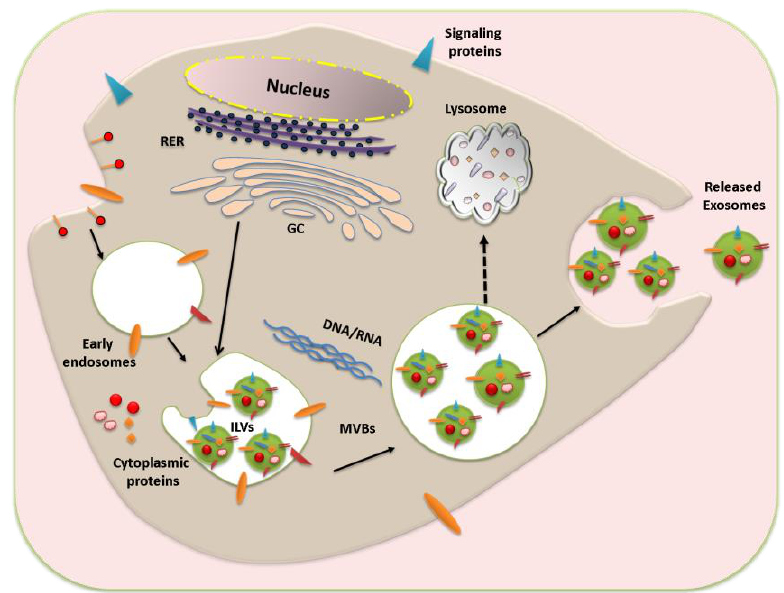
Figure 2. Schematic representation of exosome biogenesis and release. Exosome generation starts with early endosome formation during endocytosis. The membrane proteins are internalized through clathrin-coated vesicles and delivered to early endosomes. This leads to intraluminal vesicles (ILVs) formation by inward budding of the limiting membrane and multi vesicular bodies (MVBs) are formed. Upon maturation the exosome-filled MVBs are either sent to lysosomes for degradation or fused with the plasma membrane to release exosomes to the extracellular milieu. RER: Rough Endoplasmic Reticulum, GC: Golgi complex.